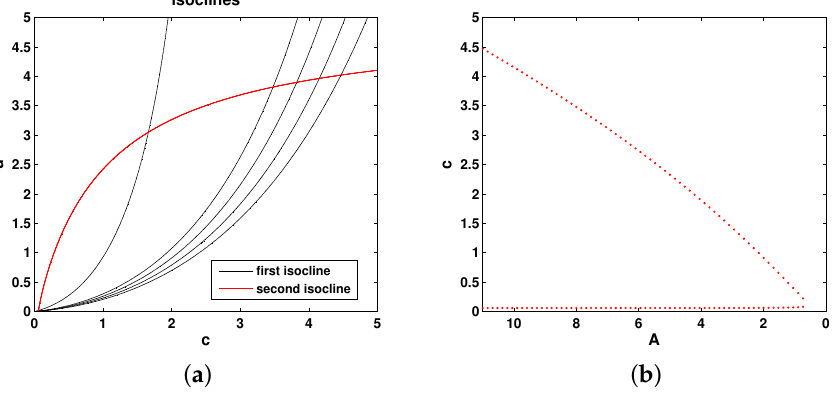
Figure 8. ( a ) The (null-)isoclines of the oxygen-phytoplankton system for Model 7. Black curves show the oxygen isocline ( u I ) for A = 3.5,8,9,10 and 11 (from left to right, respectively), and the red curve shows the phytoplankton isocline ( c II ). ( b ) Positive steady states of Equation (23) and (24) shown as functions of A . Here, ν = 0.01 and c 3 = 1, and other parameters are the same as in Figure